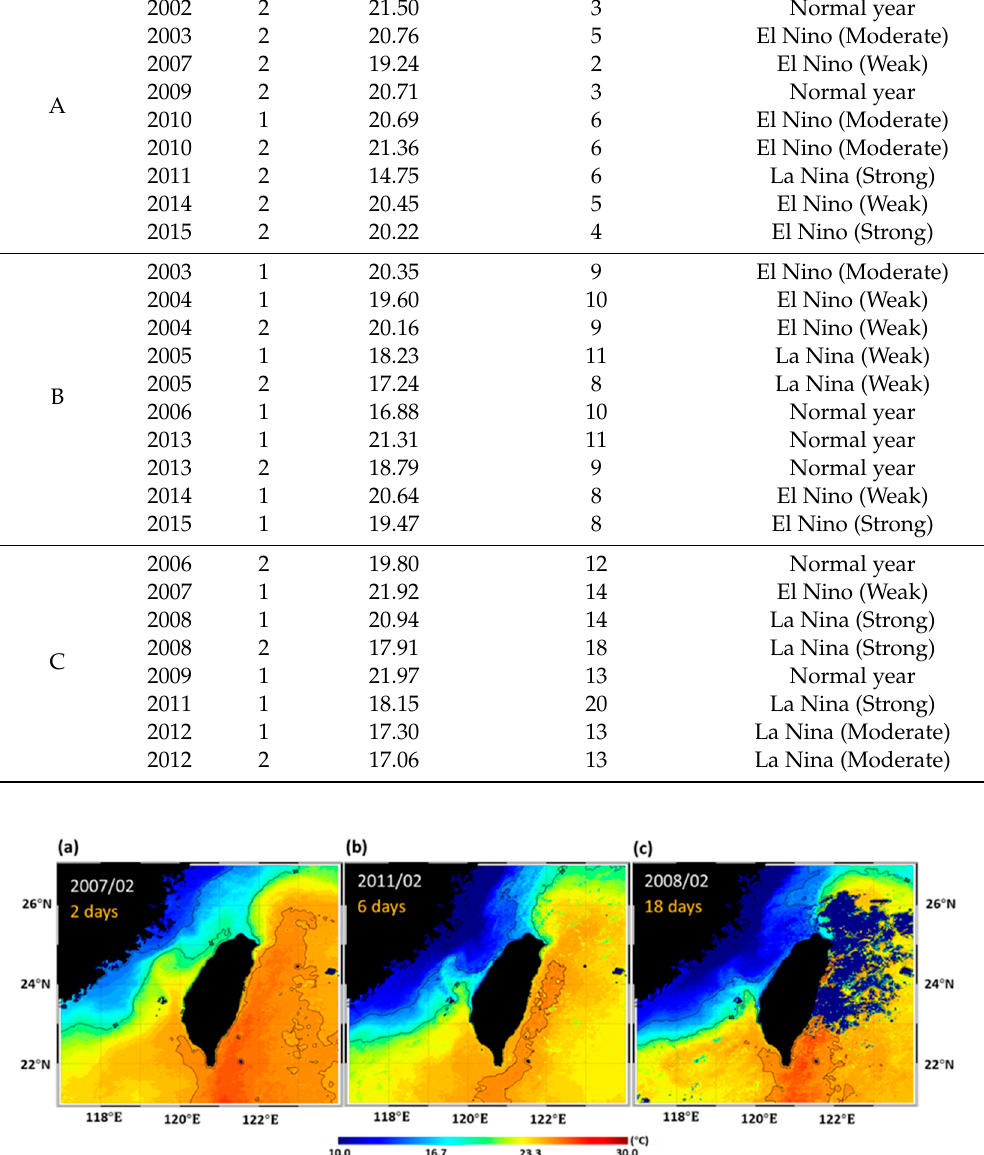
Figure 6. Time series of SSTAs for 49 grids ( a ) during 2002–2015, ( b ) for category A, ( c ) for category B, and ( d ) for category C. Red columns represent positive SSTAs and blue columns represent negative SSTAs. The lower grid cell numbers occur in the northern part of the PHI, with higher numbers towards the southern part of the study area. 3.3. Spatial Distribution of Environmental Parameters Ranked during Extreme Events The average variable influence scores of four parameters were calculated and rounded in the 49 grids during extreme events (category C). The spatial distributions of monthly SSTAs showed the northern and northwestern PHI had lower scores (1–2) (Figure 7a, grids 1–18). The high scores (5–6) were concentrated in the southern and southeastern PHI (Figure 7a, grids 19–49). The high scores of